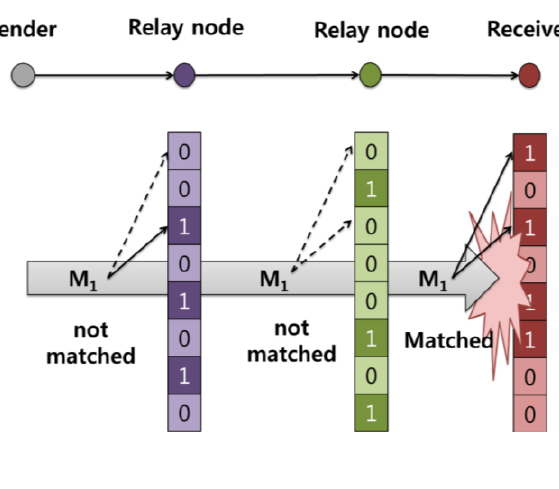
Figure 5. Operation of the distributed IDS on the network